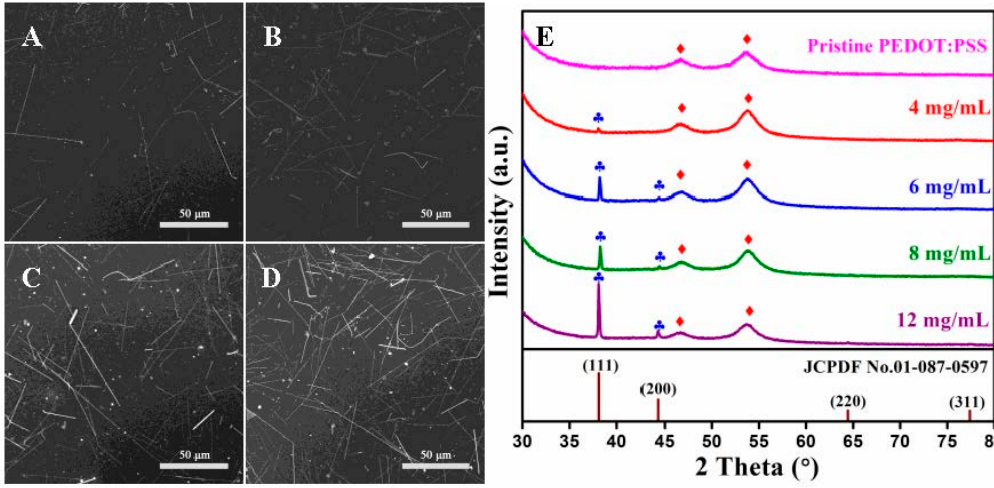
Figure 3. ( A – D ) SEM images and ( E ) XRD patterns of PEDOT:PSS/Ag NW composite films printed using the 350 mesh, and the Ag NW concentration was respectively 4, 6, 8 and 12 mg/mL in the ink.